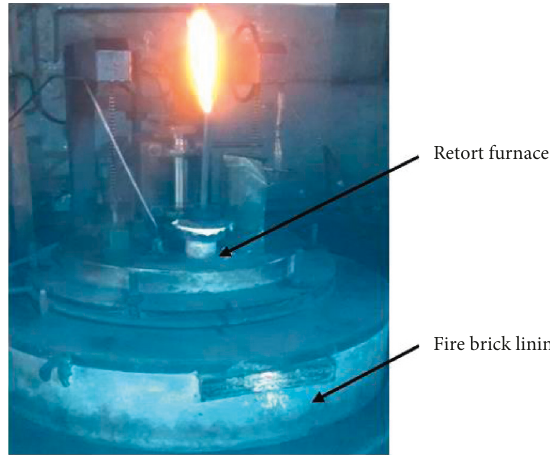
Figure 1: Gas carburizing Table 1: Levels of carburizing factors.